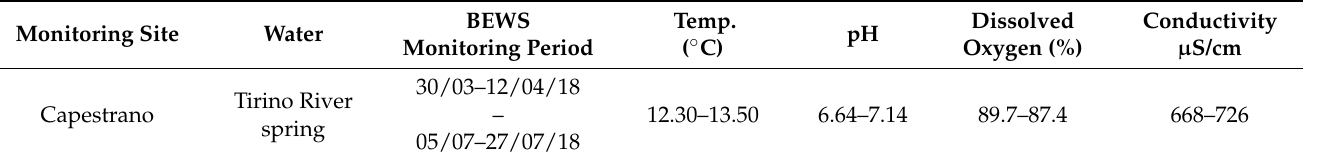
Table 1. Characteristics of the monitored